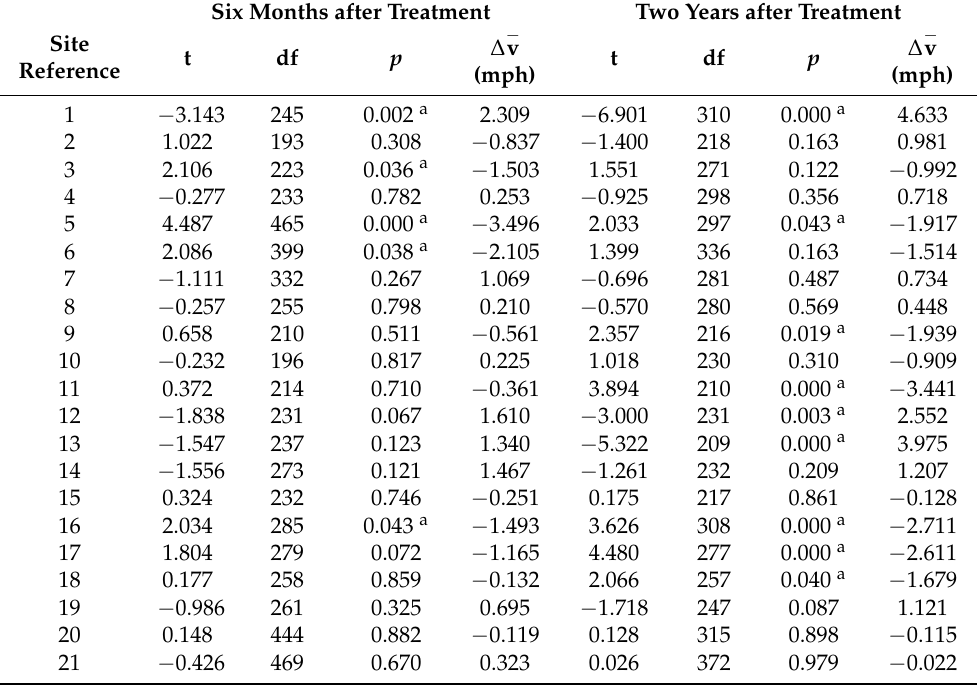
Table 4. Change in local mean speed by